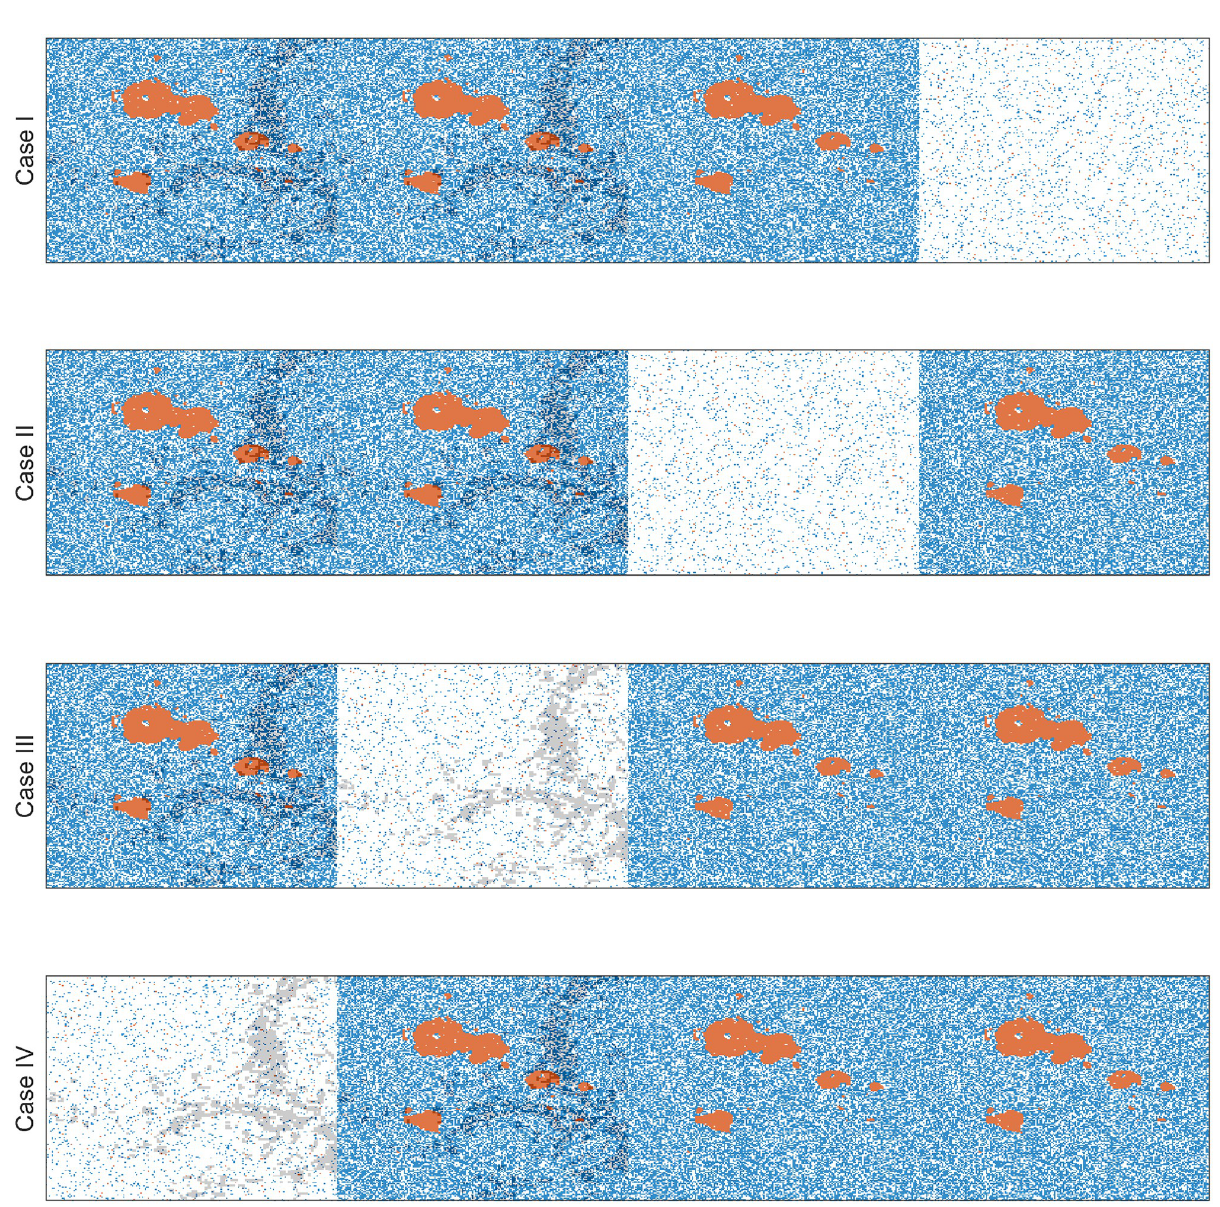
Fig 13. Initial cell configurations for the four cases with a random invisible metastasis. The red, blue, and white dots correspond to R-cells, S-cells, and empty sites. The gray dots show the sites that are accompanied by